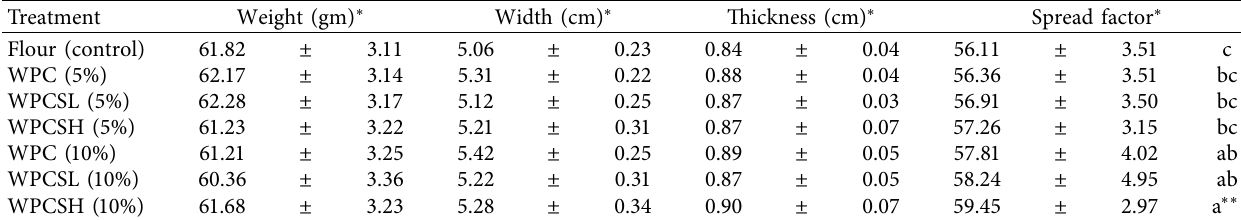
Table 4: Physical characteristics of different levels of